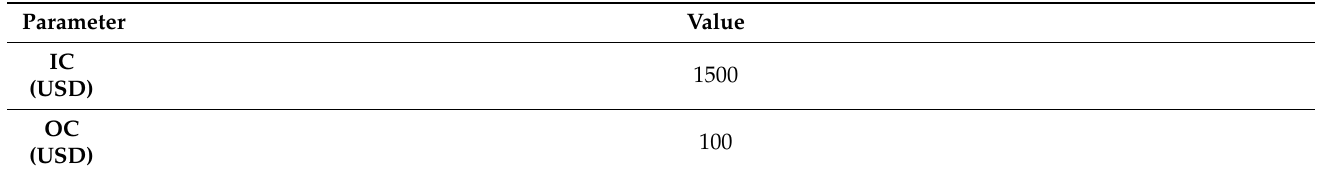
Table 4. Assumptions (‘000s)